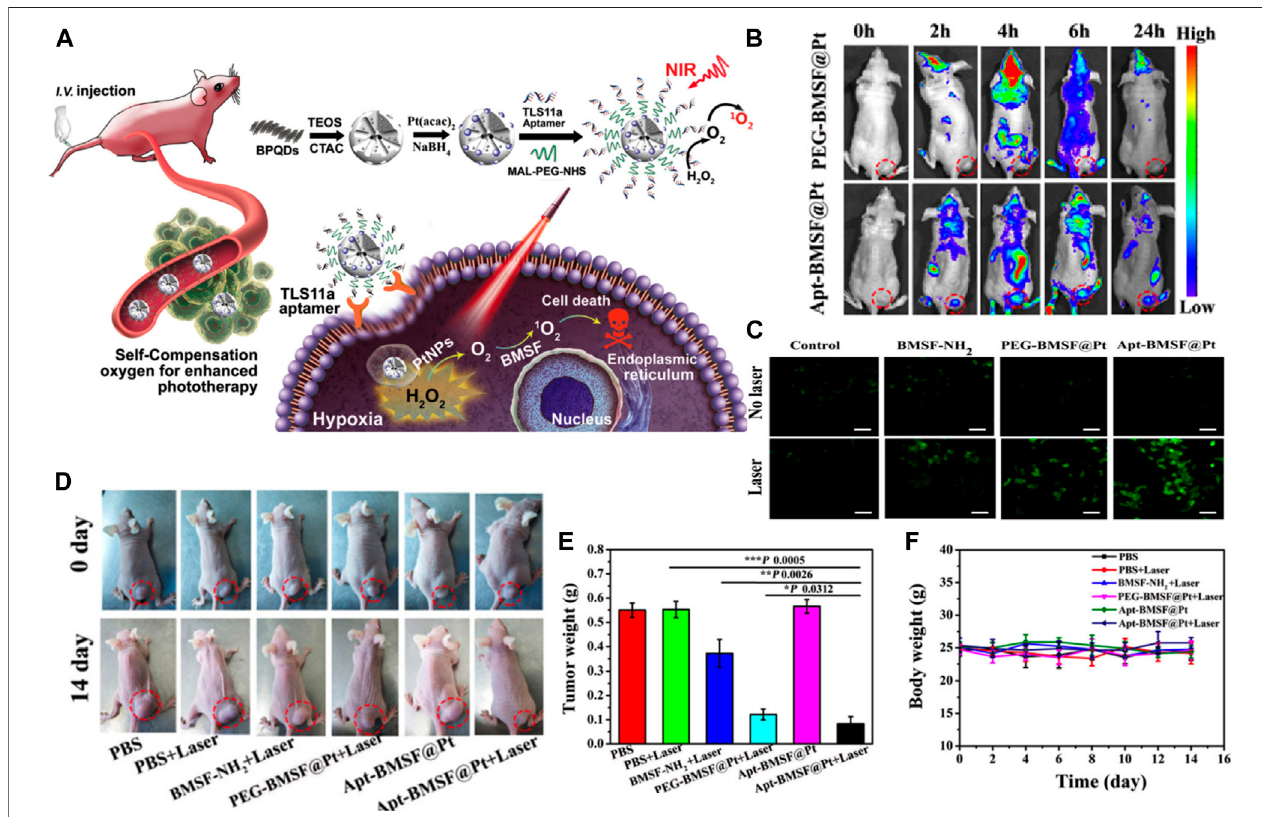
FIGURE9 |(A) Schematic illustration ofApt-BMSF@Ptand thephotocatalysis mechanism for enhancing PDT. (B) Invivo fl uorescence imagingofPEG-BMSF@Pt andApt-BMSF@Ptatdifferenttimepointsafterintravenousinjection. (C) TheDCFH-DAdetectionofintracellularROSinHepG 2 cellsafterindicatedtreatment. (D) Invivo responsetoPBS,BMSF-NH2,PEG-BMSF@Pt,andApt-BMSF@Ptwithorwithoutlaserirradiation. (E) Theaveragetumorweightofmiceafterindicatedtreatments ( n (cid:2) 5); (F) Mean body weight of mice during indicated treatments. Reprinted with permission from Lan et al. (2019). Copyright (2019) American Chemical